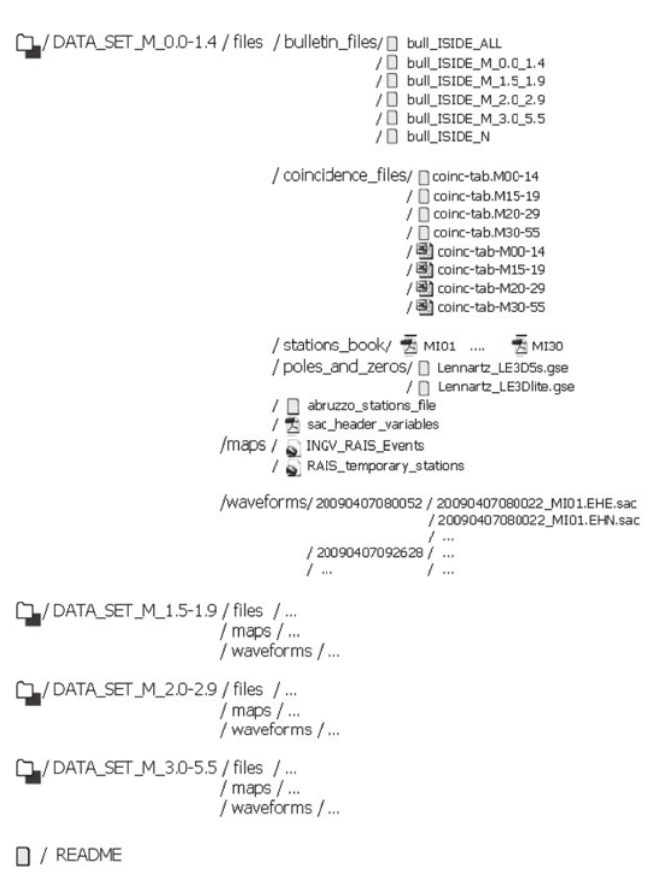
Figure 5. Dataset structure (see text for explanation).